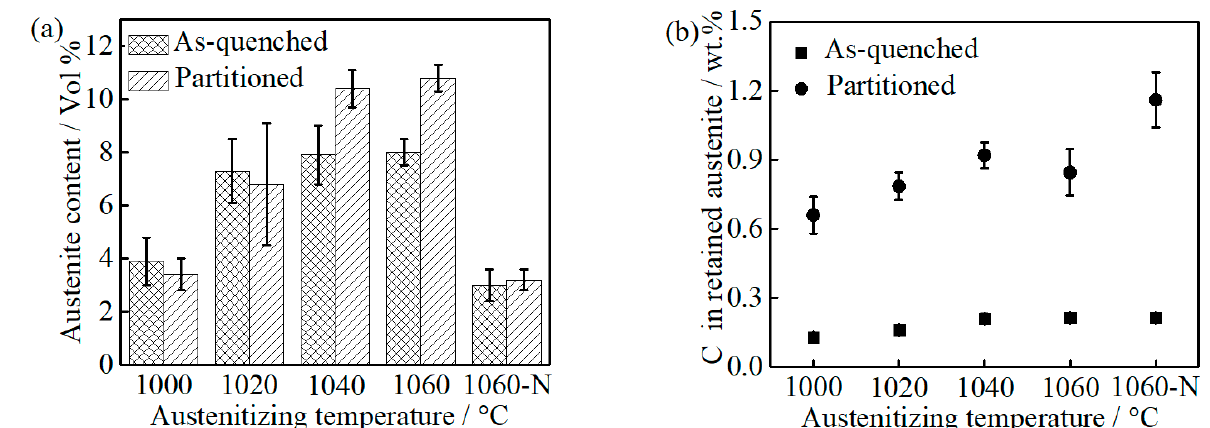
Figure 6. ( a ) Retained austenite content and ( b ) the carbon content in the retained austenite of as-quenched and partitioned samples.